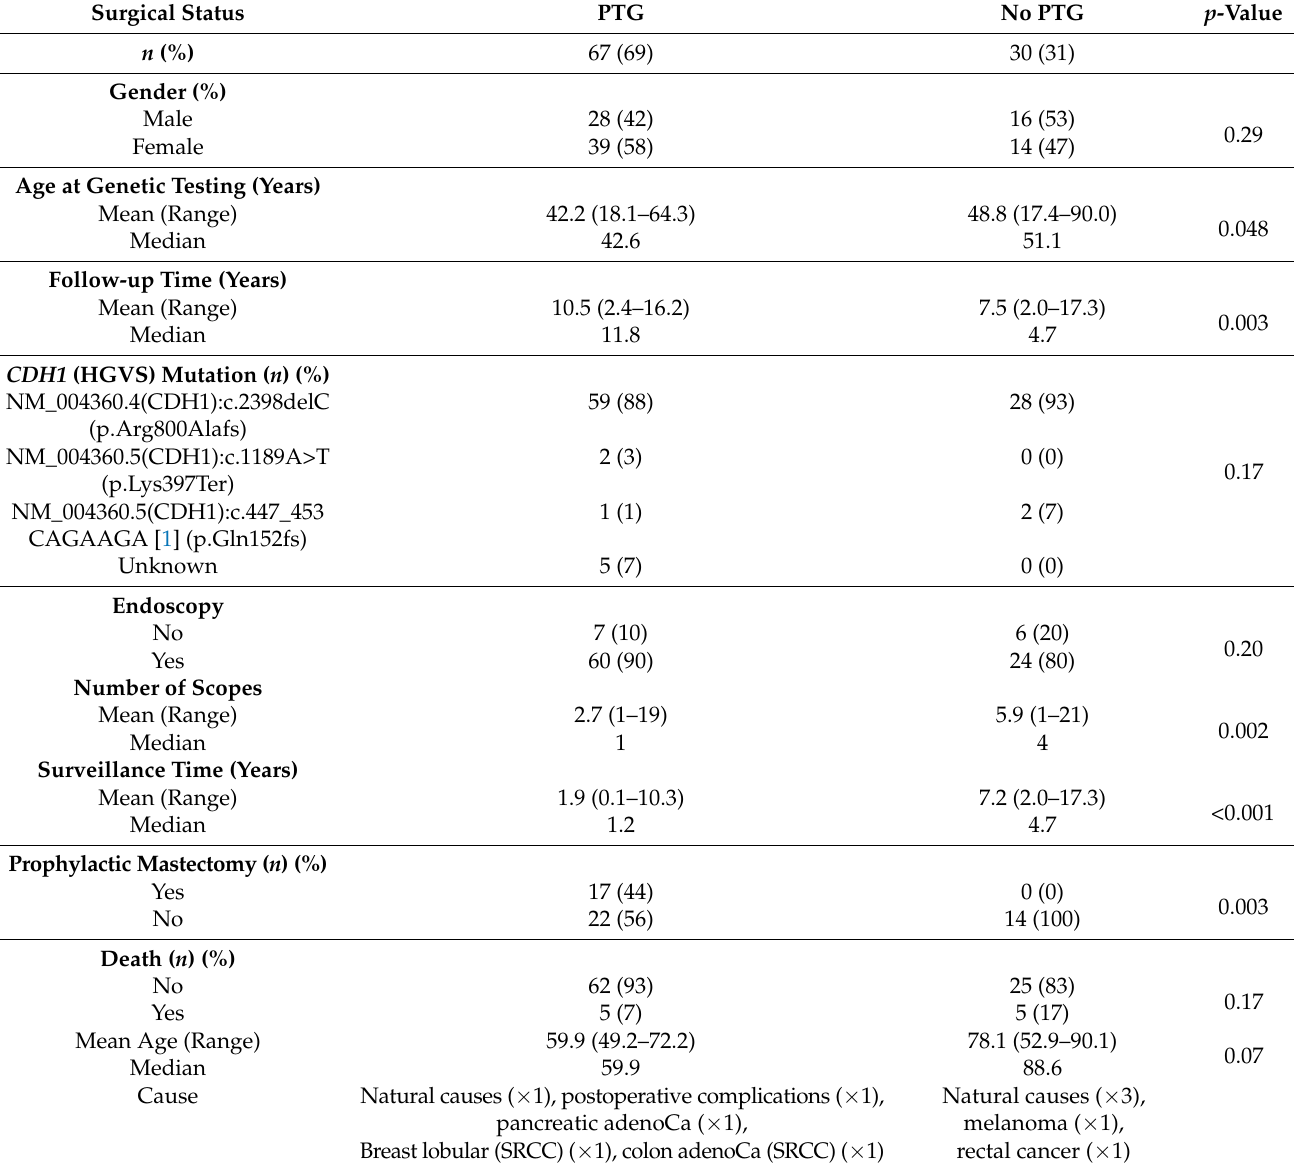
Table 1. Demographics of patients in Newfoundland and Labrador on basis of